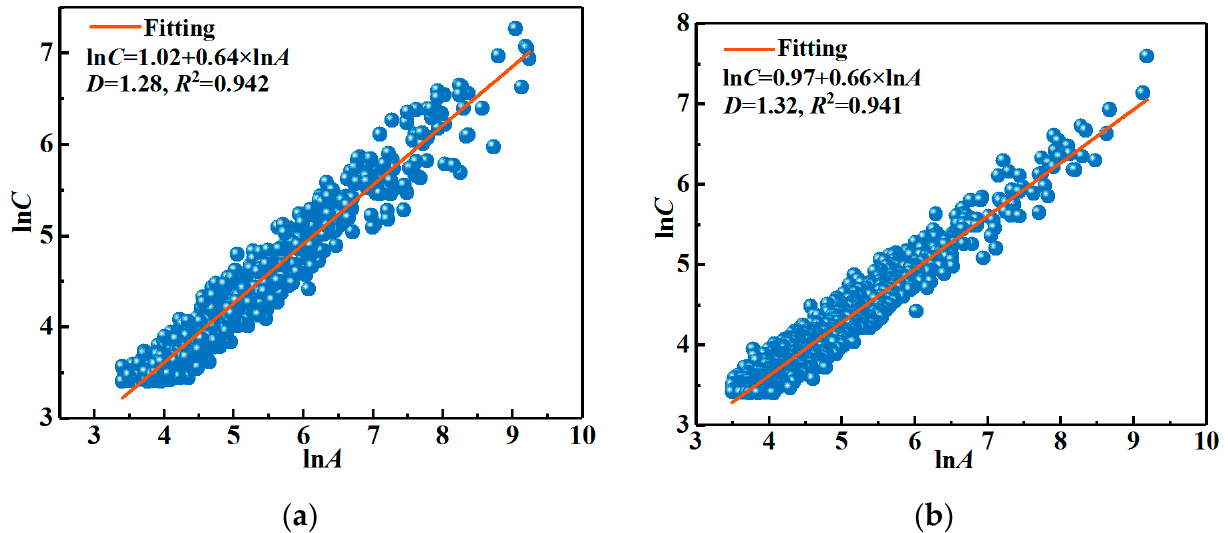
Figure 9. The fractal dimension of the pores and their fitting curve in sample ASM0 ( a ) and ASM5 ( b ).